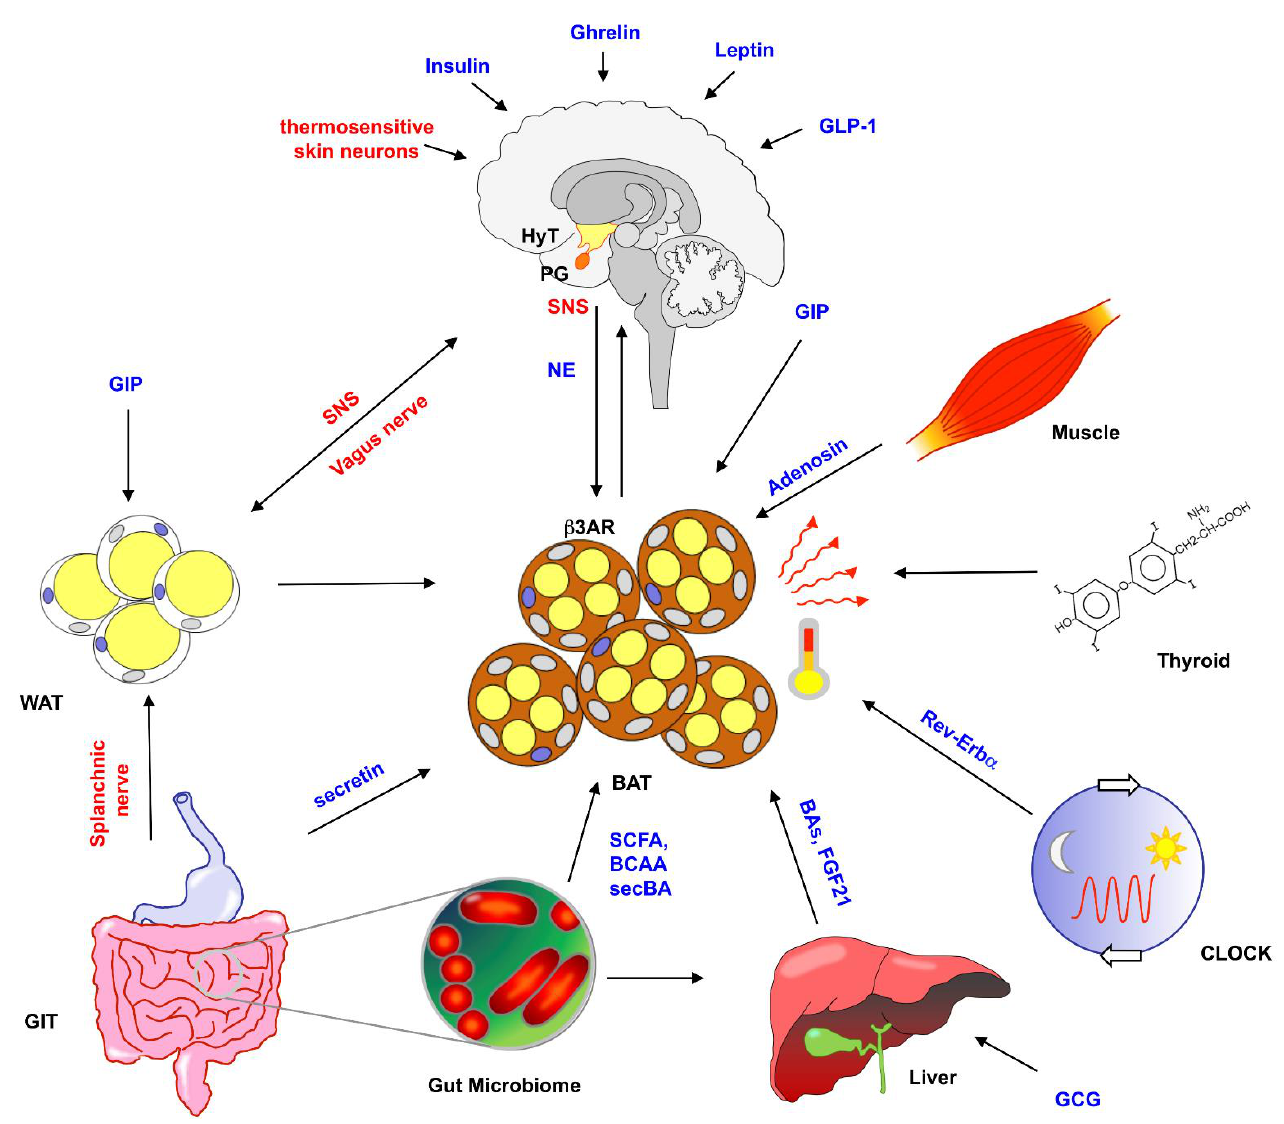
Figure 2. Multifaceted regulation of BAT activity. Thermogenic activity in brown adipose tissue (BAT) is controlled in response to cold exposure or caloric excess via various control mechanisms. These include the Sympathetic Nervous System (SNS) originating within the hypothalamus, crosstalk with White Adipose Tissue (WAT), modulation by thyroid hormones, transcriptional regulation by the circadian rhythm and input from liver, muscles and gastrointestinal tract (GIT). The latter mechanism can be mediated either directly via the secretion of gut hormones such as secretin by GIT cells or by alterations in the gut microbiome and subsequent changes in microbial metabolite profiles within the GIT or the circulation (with long-ranging effects on the entire body). Neuronal signaling routes are displayed in red, and molecules exerting signaling effects are shown in blue. BAs, bile acids, BCAA, branch-chained amino acids; GCG, Glucagon; GIP, gastric inhibitory peptide; GLP-1 Glucagon-like protein-1; HyT, hypothalamus; NE, norepinephrine; SCFA, short-chained fatty acids; secBA, secondary bile acids; SNS, sympathetic nervous system; PG, pituitary